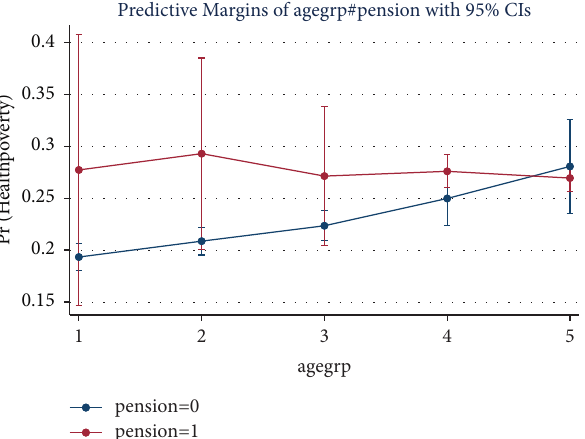
Figure 1: Health poverty changes of rural elderly people by age